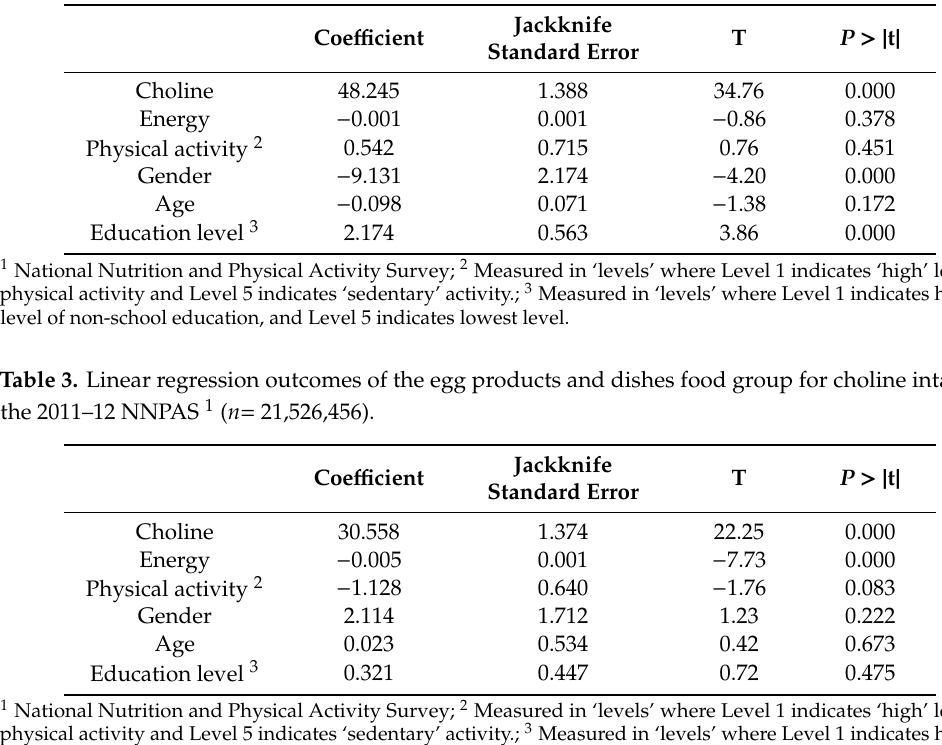
Table 2. Linear regression outcomes of the meat, poultry and game products and dishes food group for